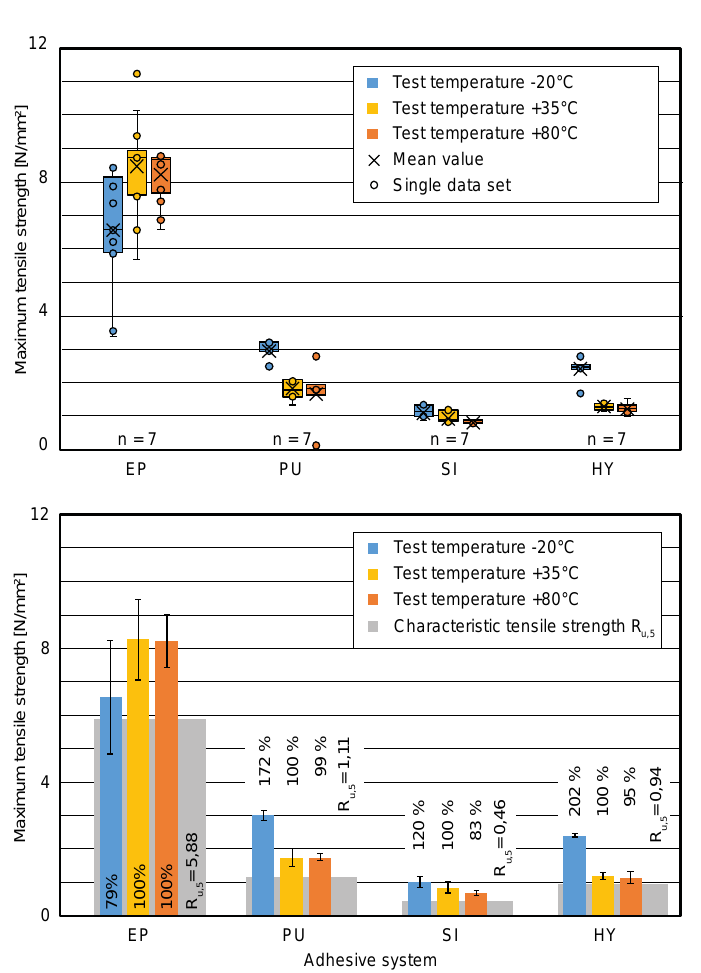
Figure 6: Maximum tensile strengths of adhesive specimens after temperature